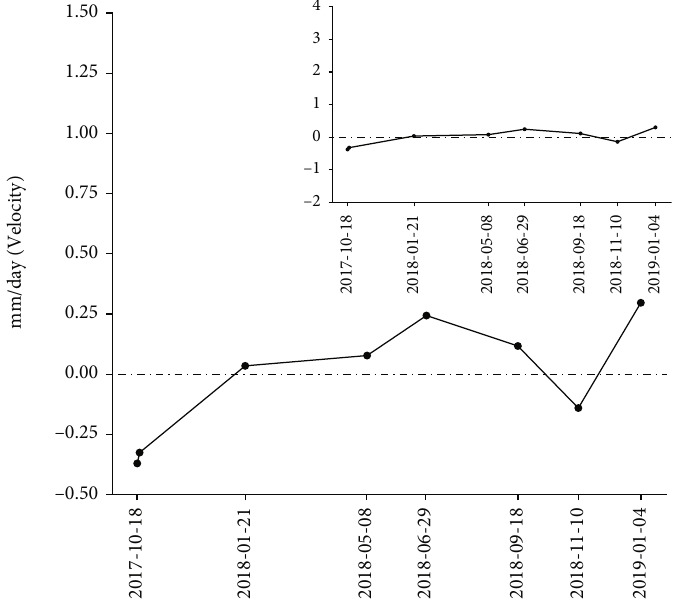
Figure 8: Displacement rate at the depth of 0.5m in ZK4-1